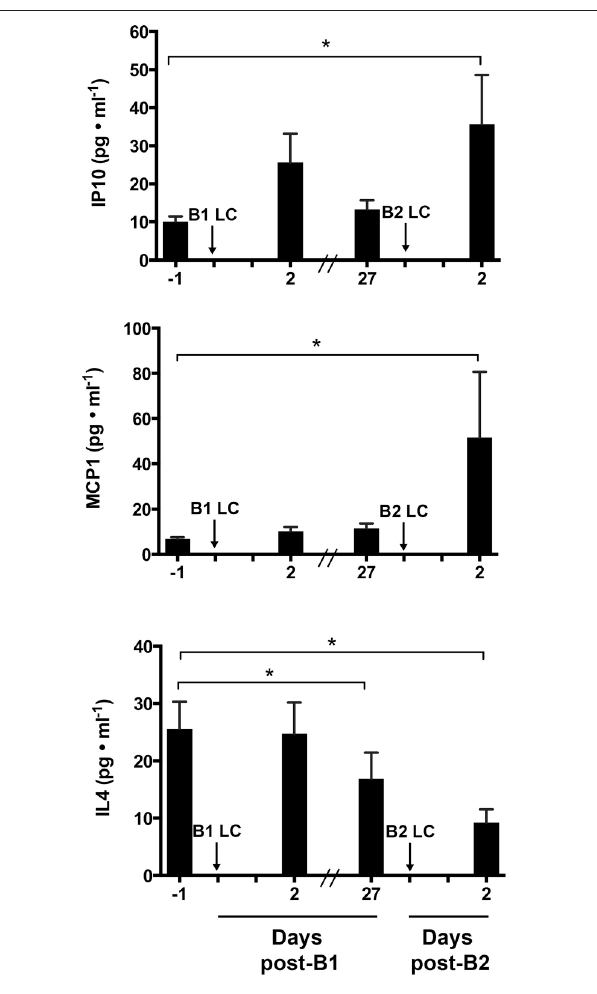
FIGURE 2 | Intramuscular cytokine protein concentration before and 2 days following the first (B1) and second bouts (B2) of lengthening contractions (LC). Abbreviations: IP-10, Interferon gamma-inducible protein 10; MCP-1, Monocyte chemoattractant protein 1; IL-4, interleukin 4. * Indicates significant differences between two samples (One-way repeated measures ANOVA with Tukey’s HSD, p < 0.05